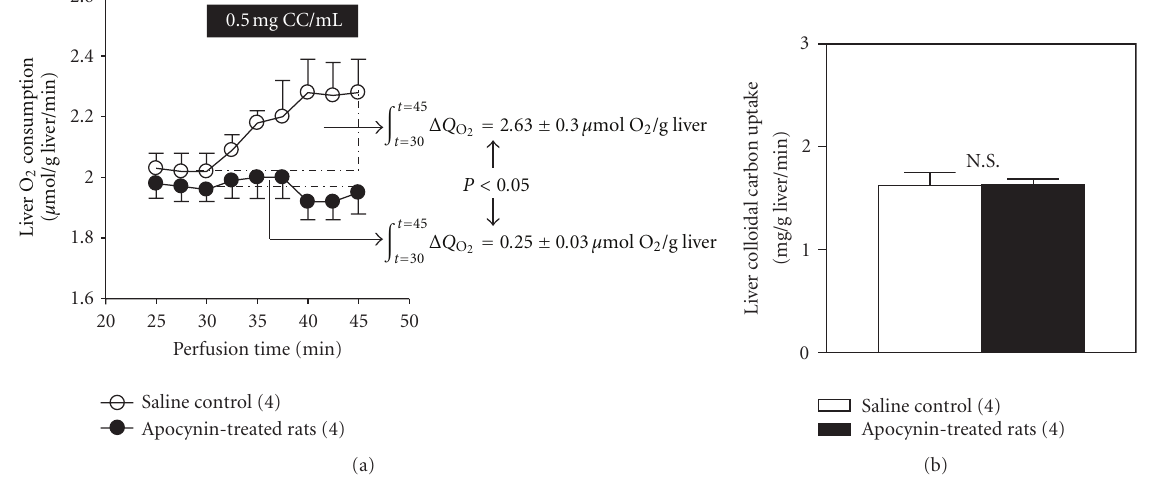
Figure 4: Apocynin administration is associated with suppression of colloidal carbon-induced liver respiratory activity ( Δ QO 2 ) assessed in isolated perfused livers from euthyroid rats (a), without altering carbon phagocytosis (b). Determinations were carried out 7 days after apocynin treatment. Δ QO 2 was calculated by integration of the area under the O 2 consumption curves between 30 and 45 min perfusion. Values shown represent means ± SEM for 4 rats per experimental group. Significance ( P < 0 . 05) was calculated by Student’s t -test for unpaired